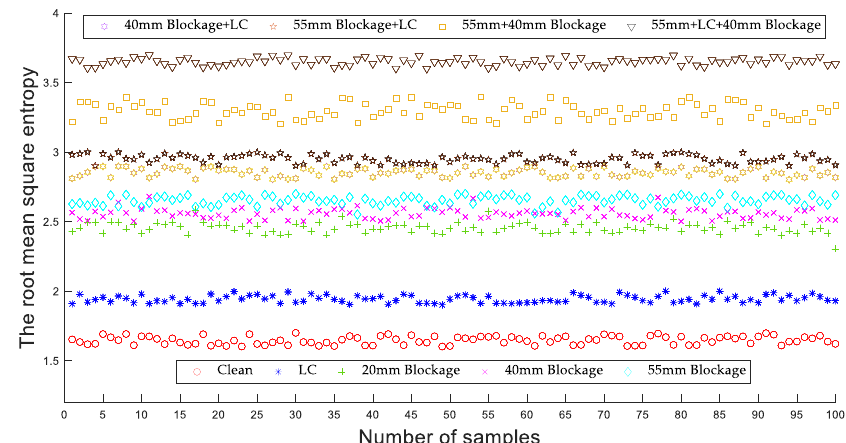
Figure 8. ERMS distributions of nine pipe operating conditions.